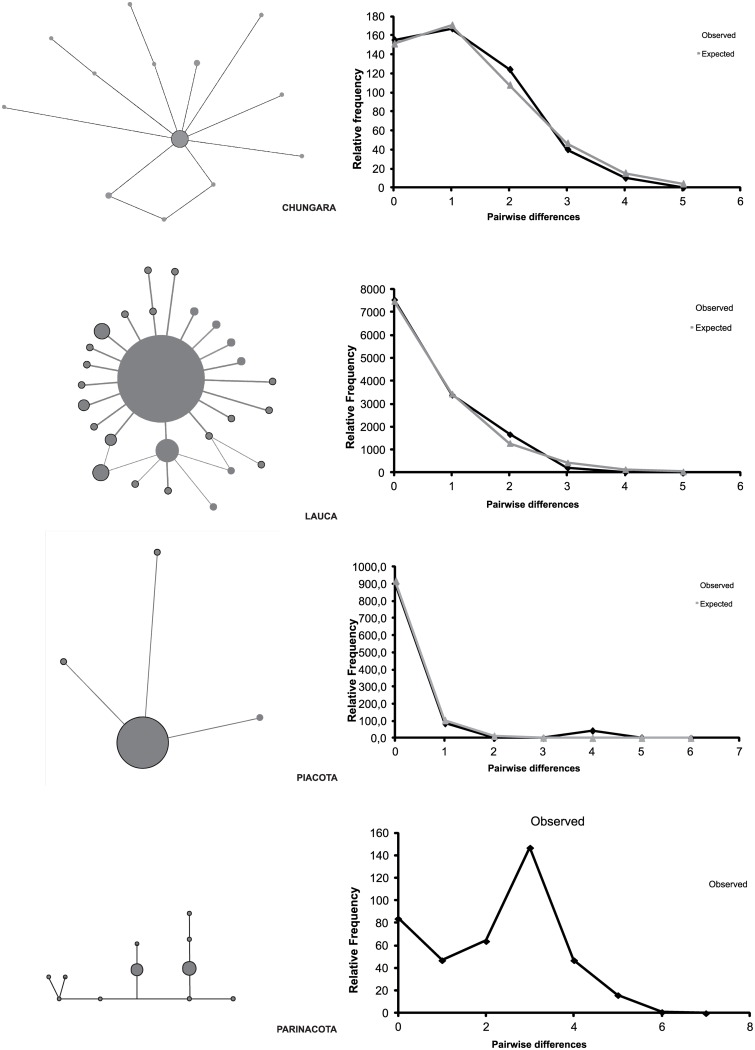
Median joining haplotype networks and the distribution of pairwise differences between haplotypes (mismatch distribution) analyses for each group obtained by SAMOVA.a) Chungará b) Lauca Group c) Piacota d) Parinacota.